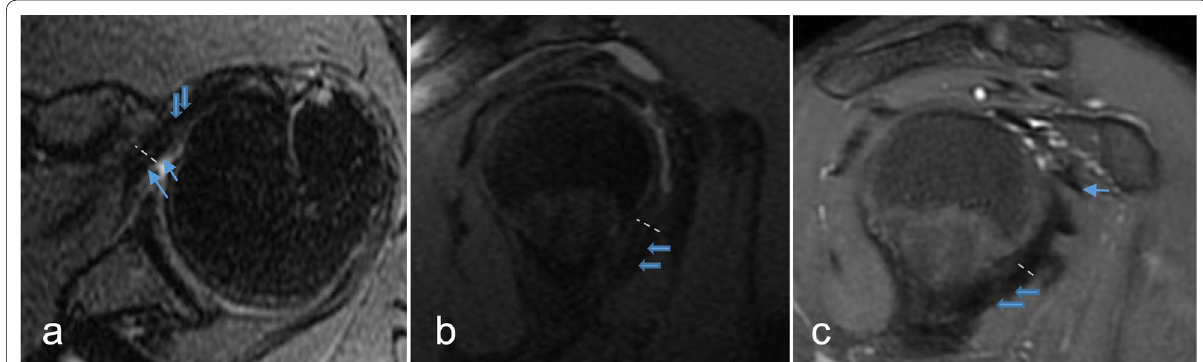
Fig. 2 Examples from a 30 year old normal male control case, illustrating the evaluation of anterior joint capsule thickness on MRI. a On axial fat-sat PD image, the dashed line represents the measurement of anterior capsule thickness at the level of the middle glenohumeral ligament (thin arrows), with the spiral glenohumeral ligament (thick arrows) crossing the superficial layer of the anterior joint capsule. b and c are Oblique sagittal PD VISTA SPAIR sequences illustrating the measurement of the thickest aspect of the anterior shoulder joint capsule (dashed line). The middle glenohumeral ligament (thin arrows) is seen continuous with the spiral glenohumeral ligament (thick arrows) in the inferior aspect of the joint